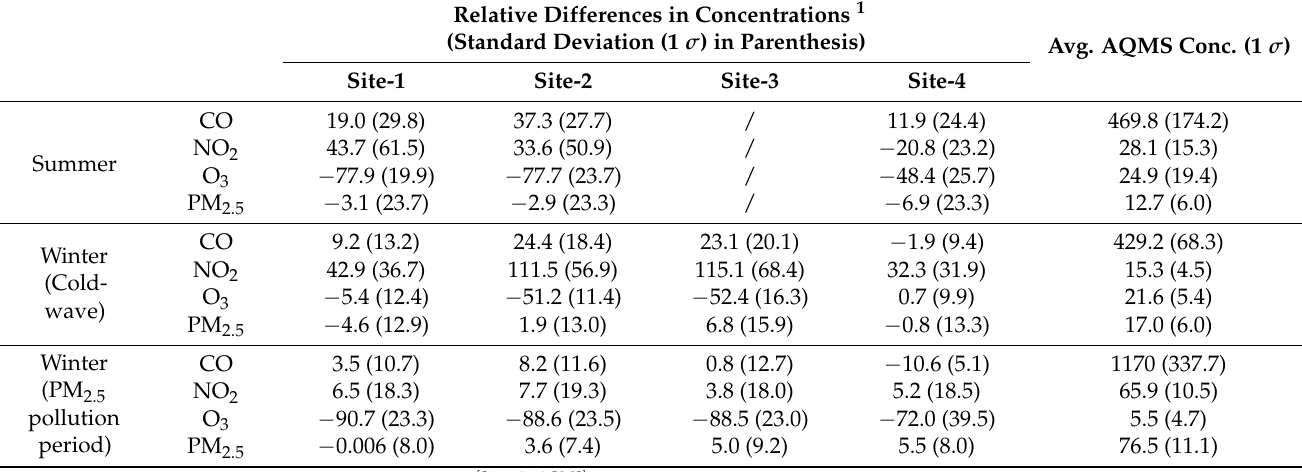
Table 3. Mean relative differences in concentrations at each sub-site with respect to the AQMS data (%) 1 (ozone data were used only for the period of 11:00–17:00 because of the near-zero roadside concentrations during the night). Relative Differences in Concentrations